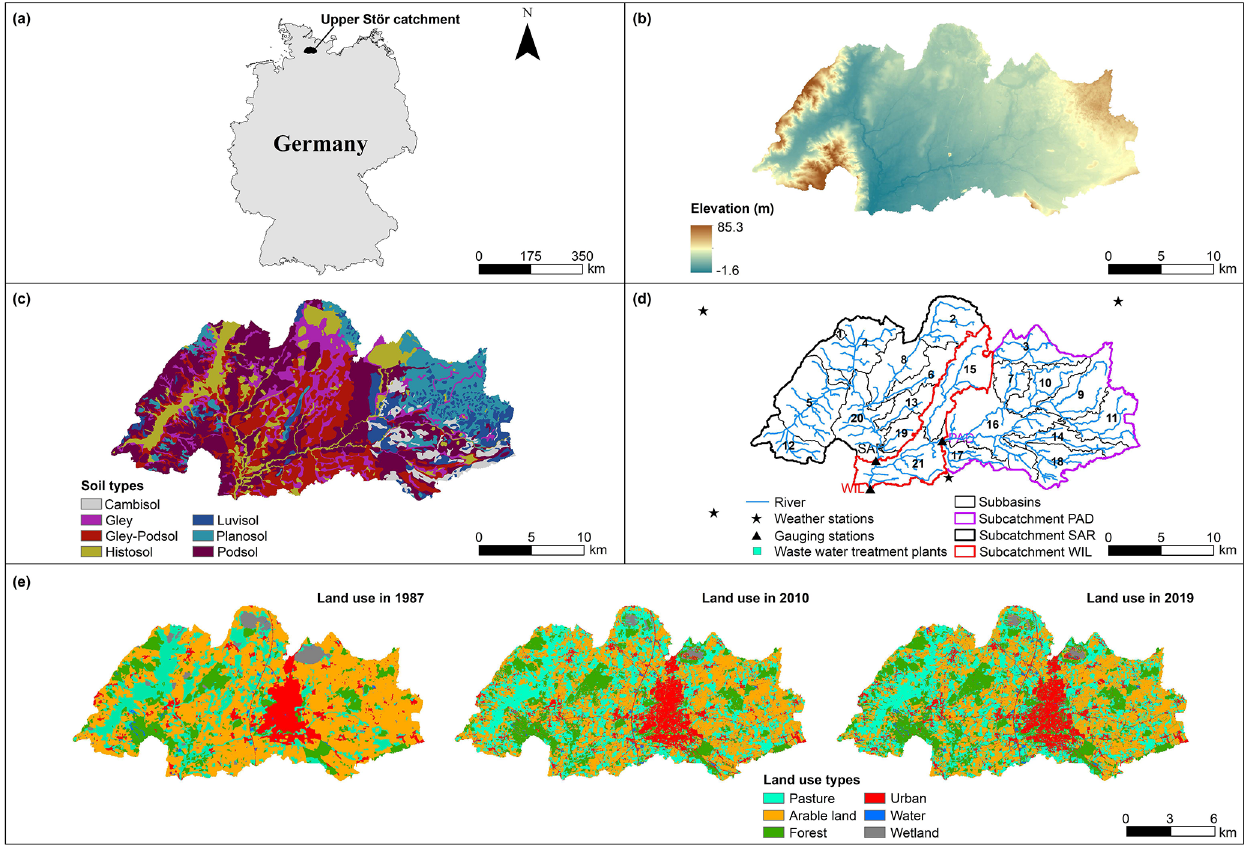
Figure 1. Characteristics of the study area. location of the Upper Stör catchment (a) , spatial distributions of the topography (b) (Lverma, 2008) and soil types (c) (Finnern, 1997) of subbasins, weather, and gauging stations, and waste water treatment plants (WWTPs) (d) (Pott, 2014), as well as land use maps (e) (Ripl et al., 1996; Rathjens et al., 2014; Lei et al.,